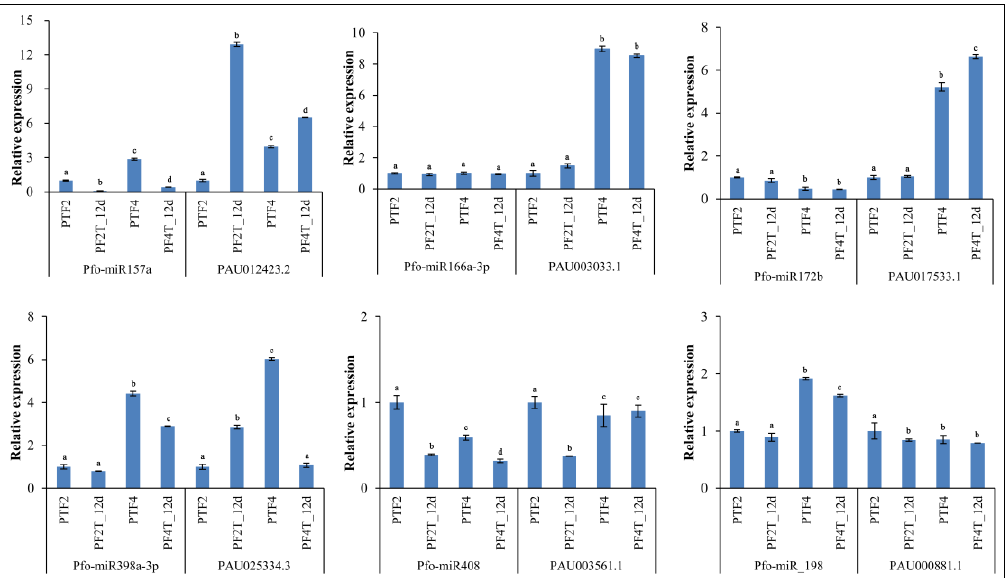
Figure 8. Relative expression of the target genes of six P. fortunei miRNAs by Quantitative Real-Time Polymerase Chain Reaction (qRT-PCR) assay . PF2, well-watered diploid; PF2T_12d, 12 days drought-treated diploid; PF4, well-watered autotetraploid; PF4T_12d, 12 days drought-treated autotetraploid. The different letters within a miRNA expression or a gene expression indicate significant difference, while the same letters within a miRNA expression or a gene expression indicate no significant differences ( p < 0.05).